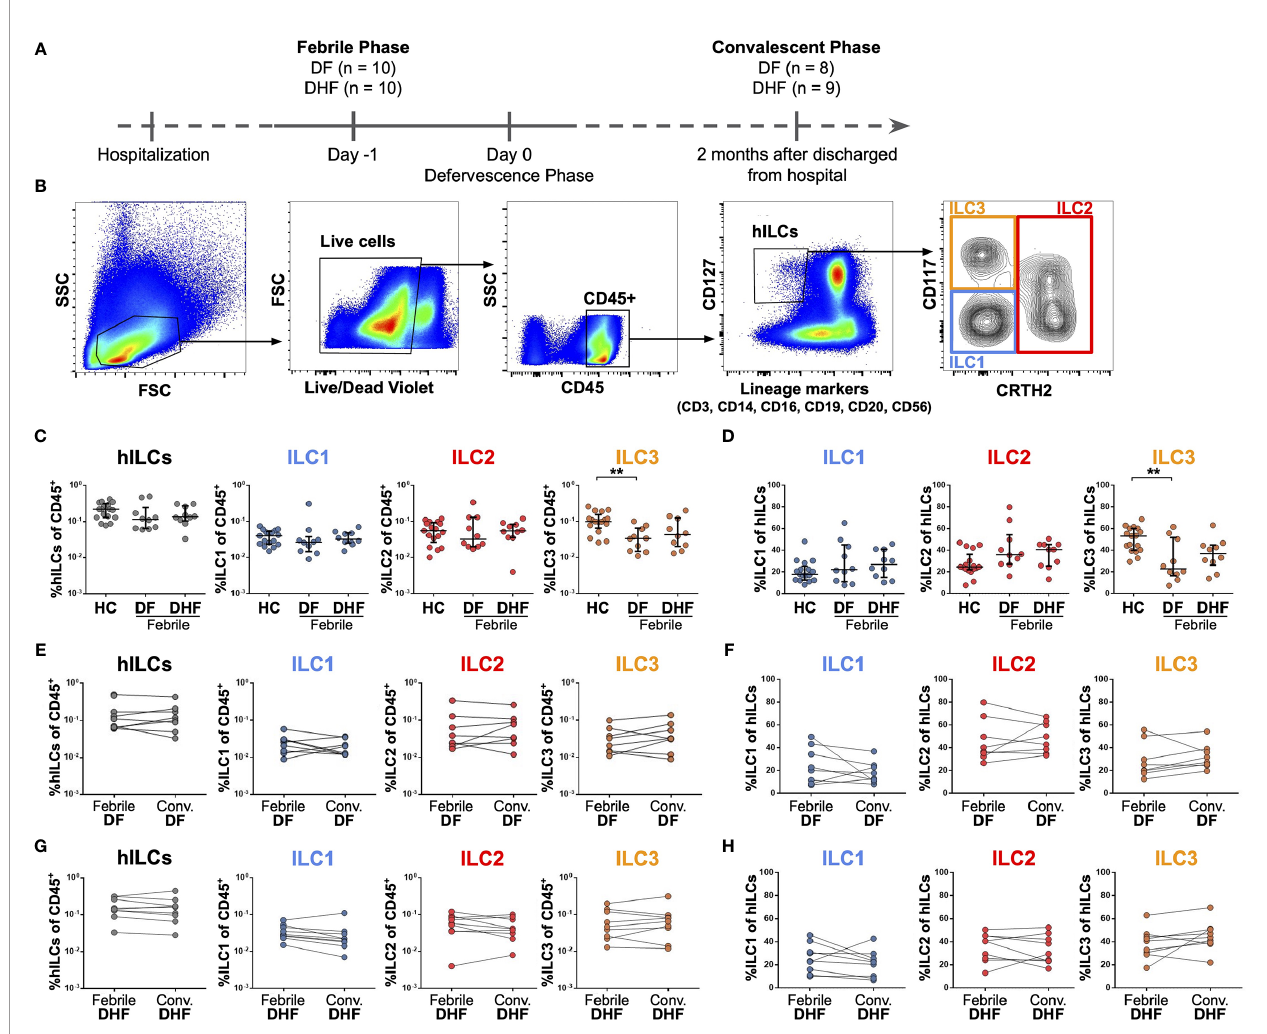
FIGURE 1 | Frequencies of hILCs during the course of DENV infection. (A) Study design (B) Flow cytometry analysis gating strategy for hILCs and their subsets from PBMC. (C, D) Percentage of total hILCs and hILC subsets in febrile phase of dengue fever (DF), dengue hemorrhagic fever (DHF) patients and healthy donors (HC). ILC subsets frequencies were determined by percentage of CD45+ lymphocyte (C) or total hILCs (D) . (E, F) Percentage of total hILCs and ILC subsets of matched samples at febrile and convalescent phases of DF patients. ILC subset frequencies were determined by percentage of CD45+ lymphocyte (E) or total hILCs (F) . (G, H) Percentage of total hILCs and ILC subsets of matched samples at febrile and convalescent phases of DHF patients. ILC subsets frequencies were determined by percentage of CD45+ lymphocyte (G) or total hILCs (H) . The results were presented as Median ± IQR. Data were analyzed using Mann-Whitney test (C, D) or Wilcoxon matched-pairs signed rank test (E – H) (** p <